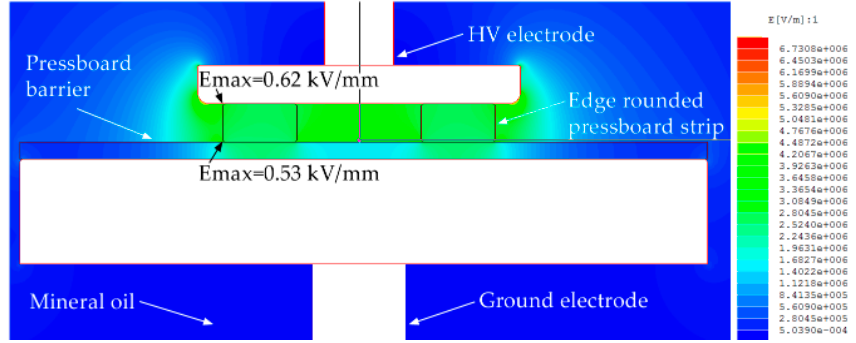
Figure 8. Analysis of electric field distribution in the oil-paper insulation model investigated here ( U = 30 kVrms).